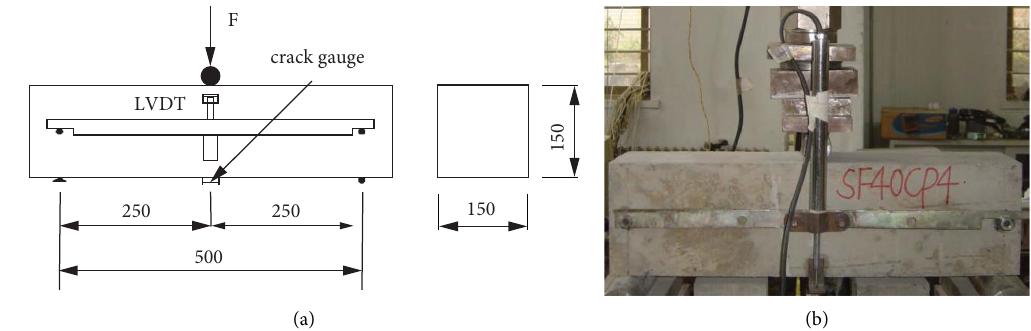
Figure 4: Flexural test of hybrid fber-reinforced SCC beams. (a) Test design. (b) Test